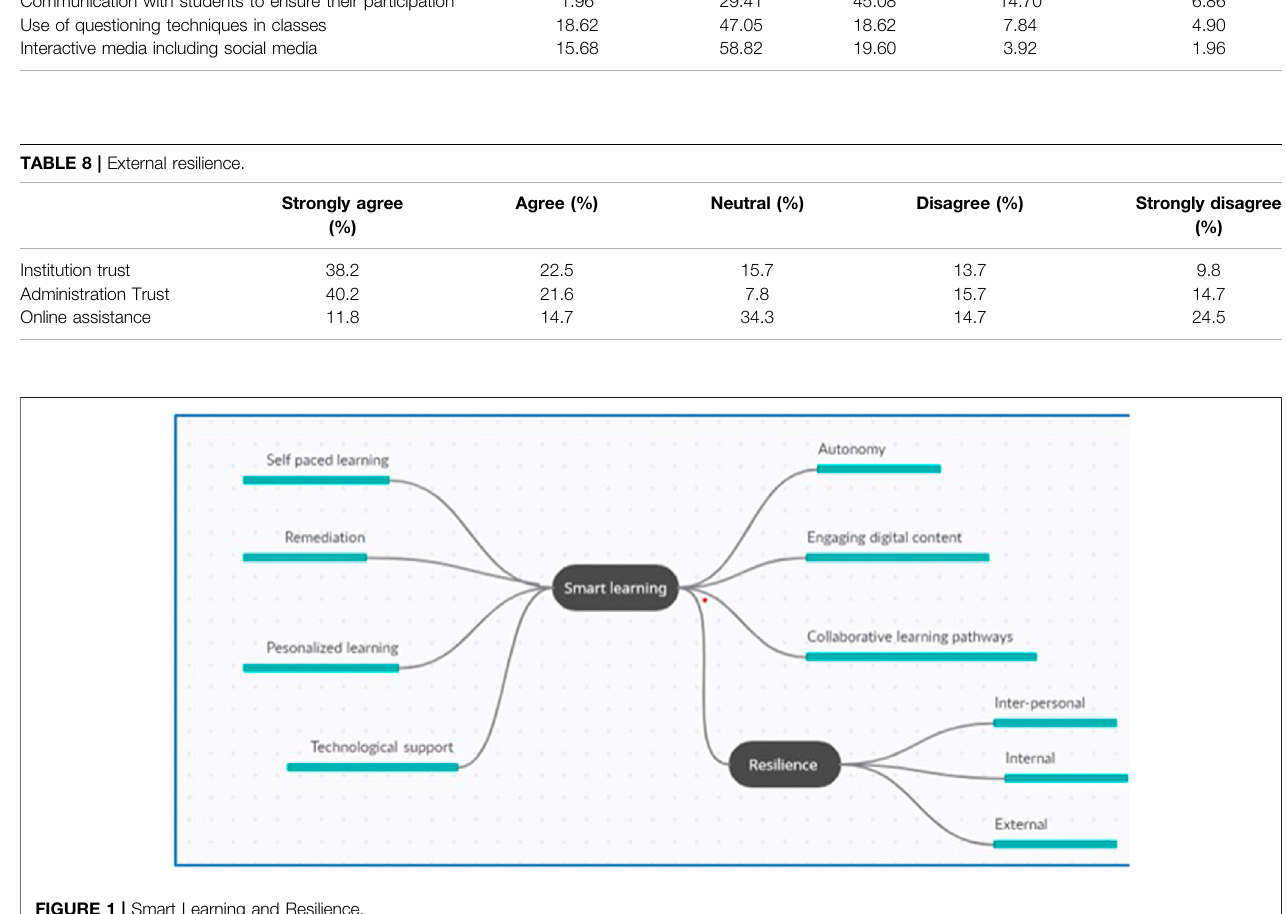
TABLE 7 | Interpersonal resilience. Engaging students so that they were attentive